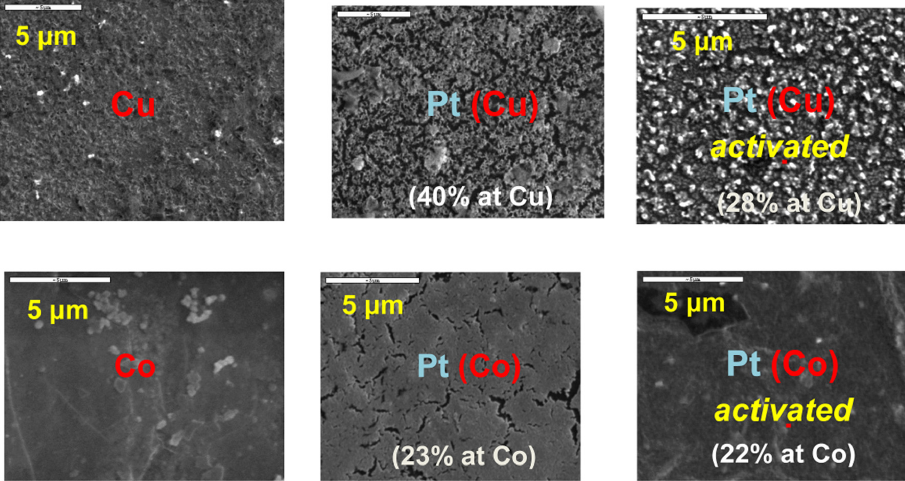
Figure 3. Scanning Electron Microscope (SEM) micrographs of Cu and Co electrodeposits on a GC substrate, Pt(Cu), and Pt(Co) layers formed via galvanic replacement and the same layers after exposure to positive potentials for electrochemical etching of uncovered Cu and Co (Reproduced with permission from [101]. Copyright 2007, Elsevier; Reproduced with permission from [103]. Copyright 2008, Elsevier). First row, left to right: Cu, Pt(Cu), activated Pt(Cu); Bottom row, left to right: Co, Pt(Co), activated Pt(Co). The composition depicted corresponds to the atomic percentage of Cu or Co in the bimetallic Pt(Cu) or Pt(Co) layers, as measured by Energy Dispersive X-ray Spectroscopy